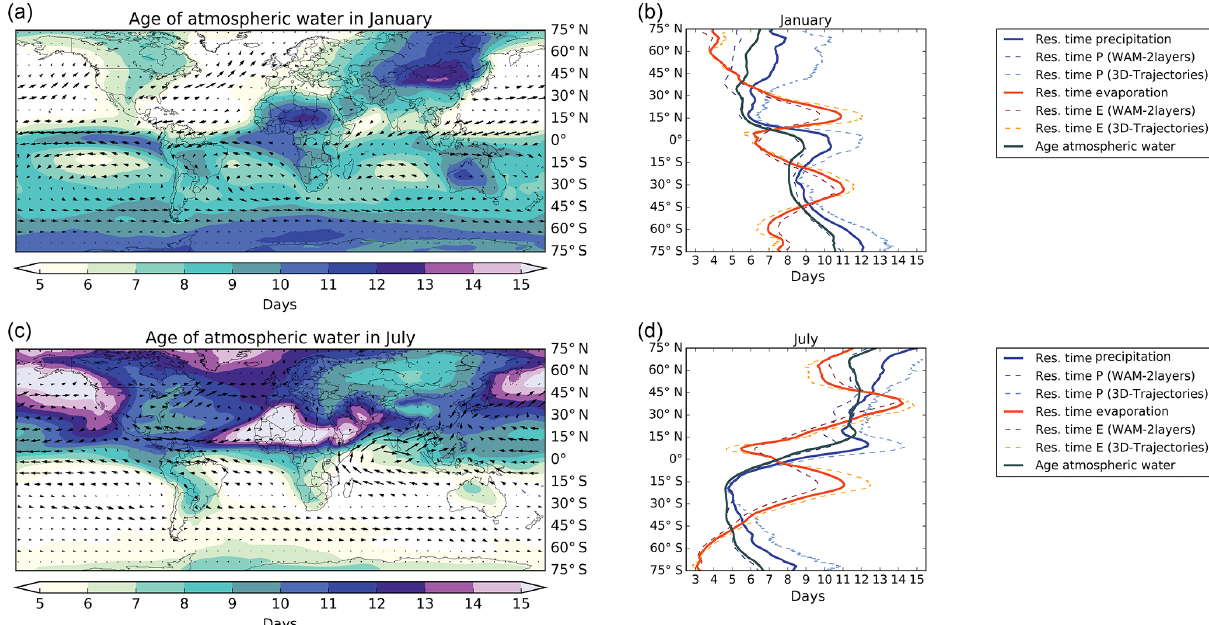
Figure 3. Time metrics in January and July. (a) Time-averaged age of atmospheric water in January (2002–2008) as computed by WAM- 2layers based on ERA-Interim data. The arrows indicate the vertically integrated moisture fluxes. (b) Latitudinal averages of residence times and water age in January. (c) As (a) for July. (d) As (b) for July. The spatial residence time figures for January and July can be found in the Supplement (Fig. S2).